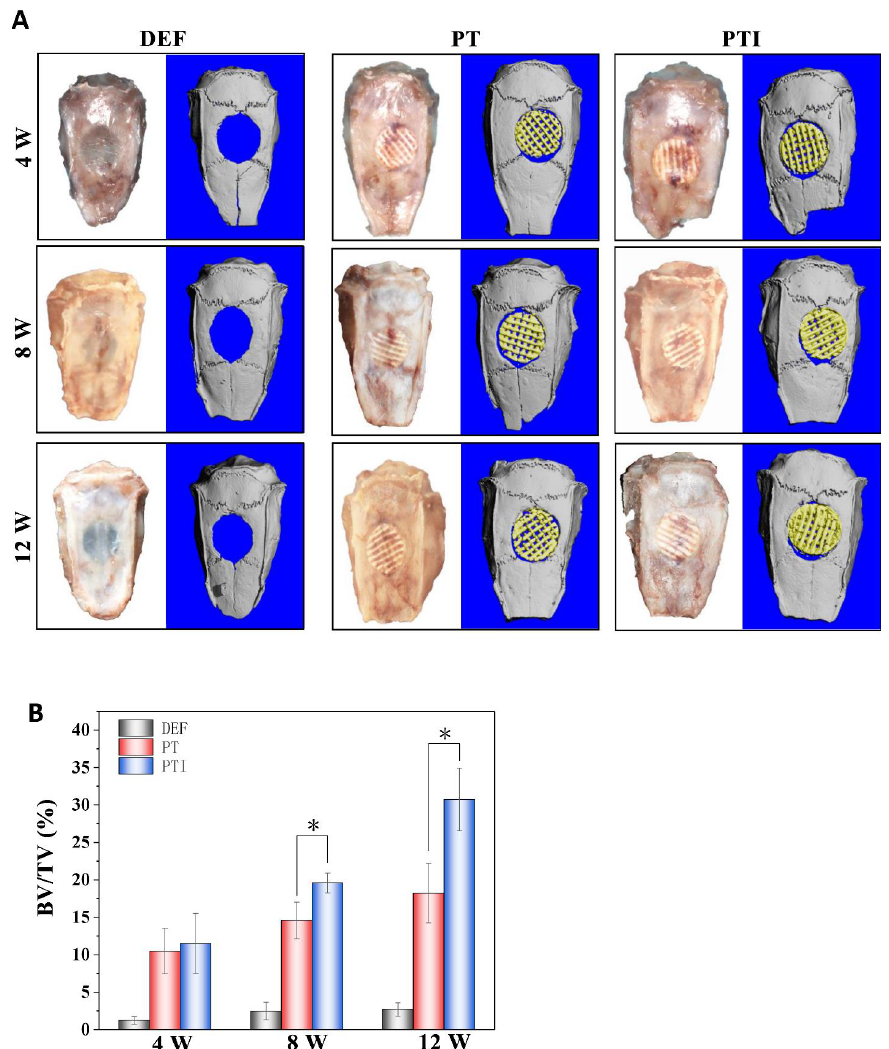
Figure 11. Micro-CT analysis and reconstruction results. ( A ) Three-dimensional reconstruction image of each specimen group; ( B ) BV/TV of defect site in PT and PTI groups at 4, 8, and 12 weeks ( n = 3, * p < 0.05).